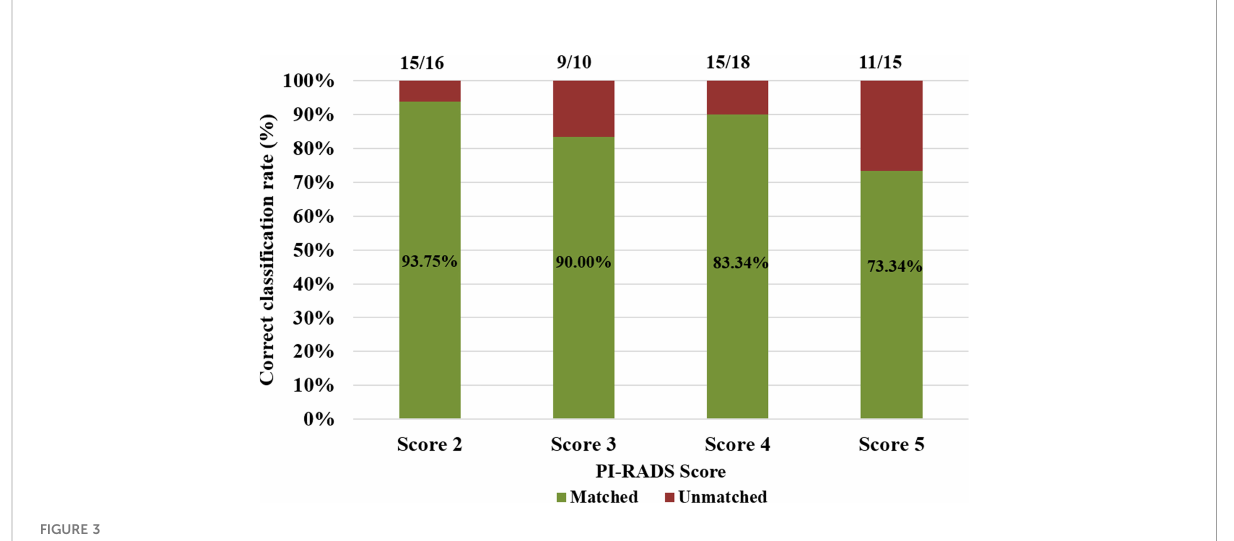
FIGURE 3 Proportion of the detection rate across all PI-RADS v2.1